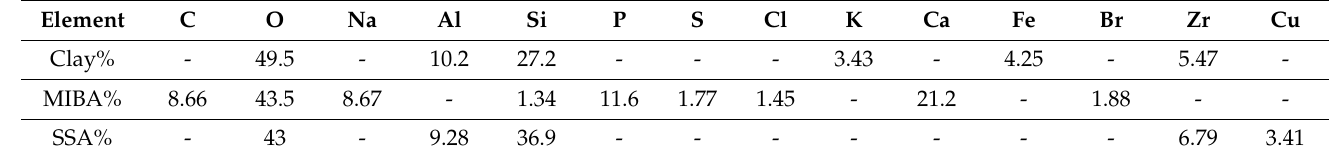
Table 2. EDS results of the raw